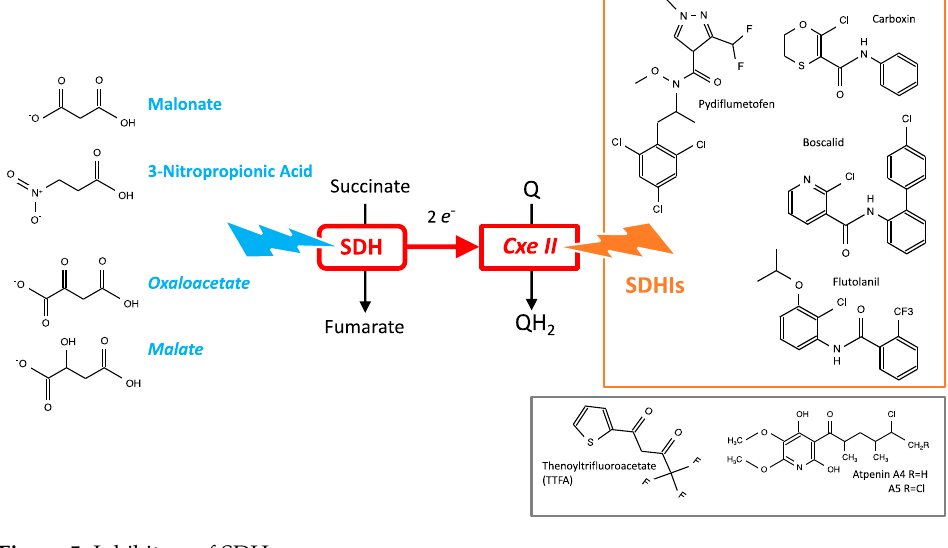
Figure 5. Inhibitors of